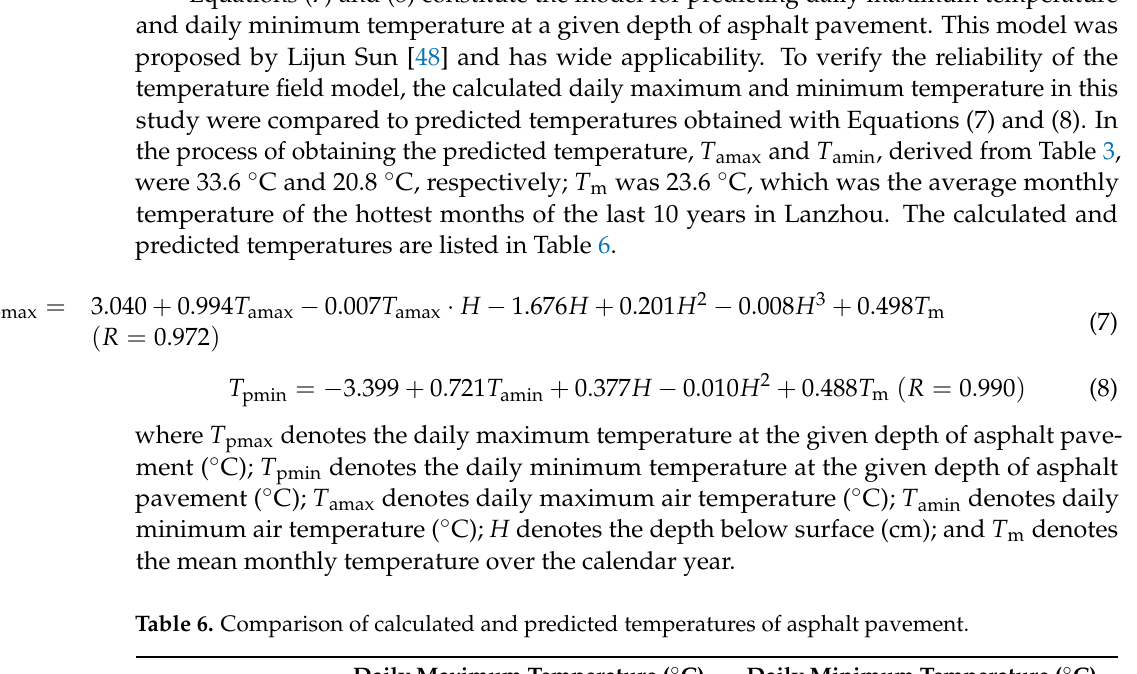
Table 6. Comparison of calculated and predicted temperatures of asphalt pavement. Daily Maximum Temperature ( ◦ C) Daily Minimum Temperature ( ◦ C) Depth below Calculated Predicted Calculated Predicted Surface (cm) Temperature Temperature Temperature